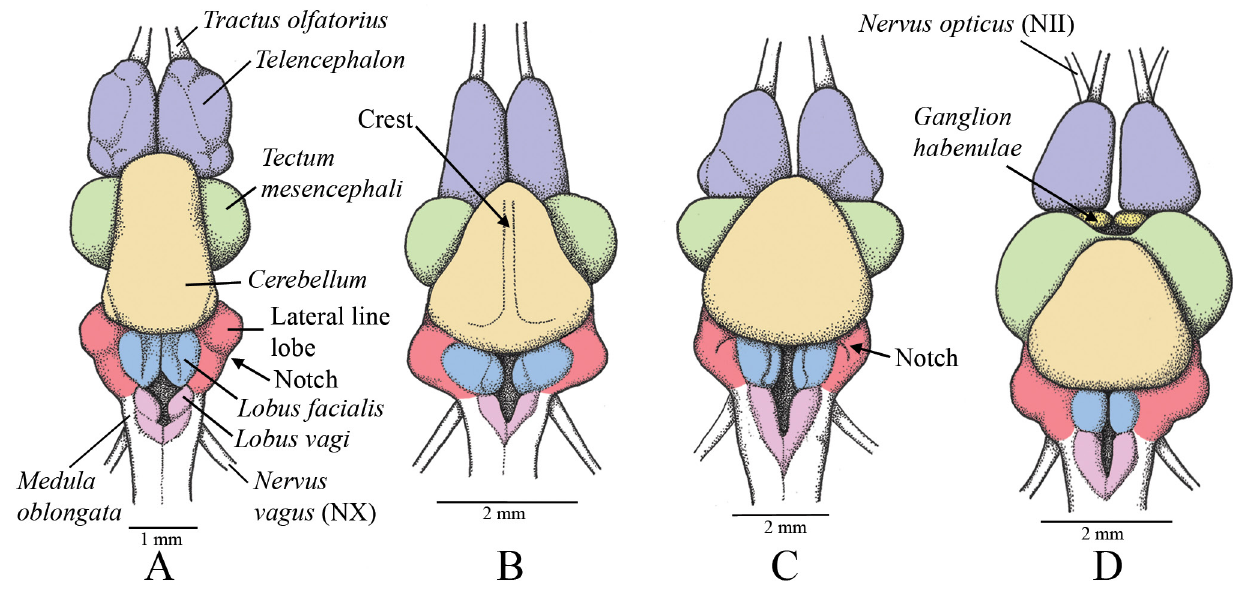
FIGURE 10 | Dorsal view of brain; anterior up: A. Rhamdia quelen , MZUEL 6036, 222.4 mm SL; B. Rhyacoglanis paranensis , MZUEL 6034, 39.2 mm SL; C. Cruciglanis pacifici , MCP non-catalogued, 142.4 mm SL; D. Lophiosilurus alexandri , MZUEL 5377, 58.7 mm